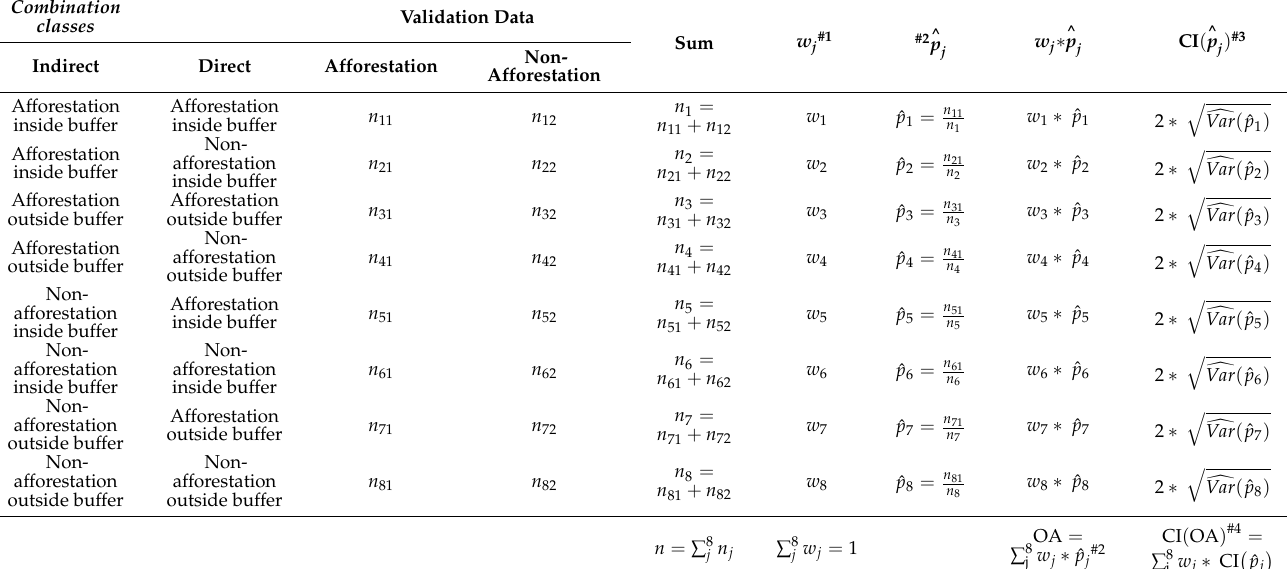
Table 4. Accuracy assessment for indirect